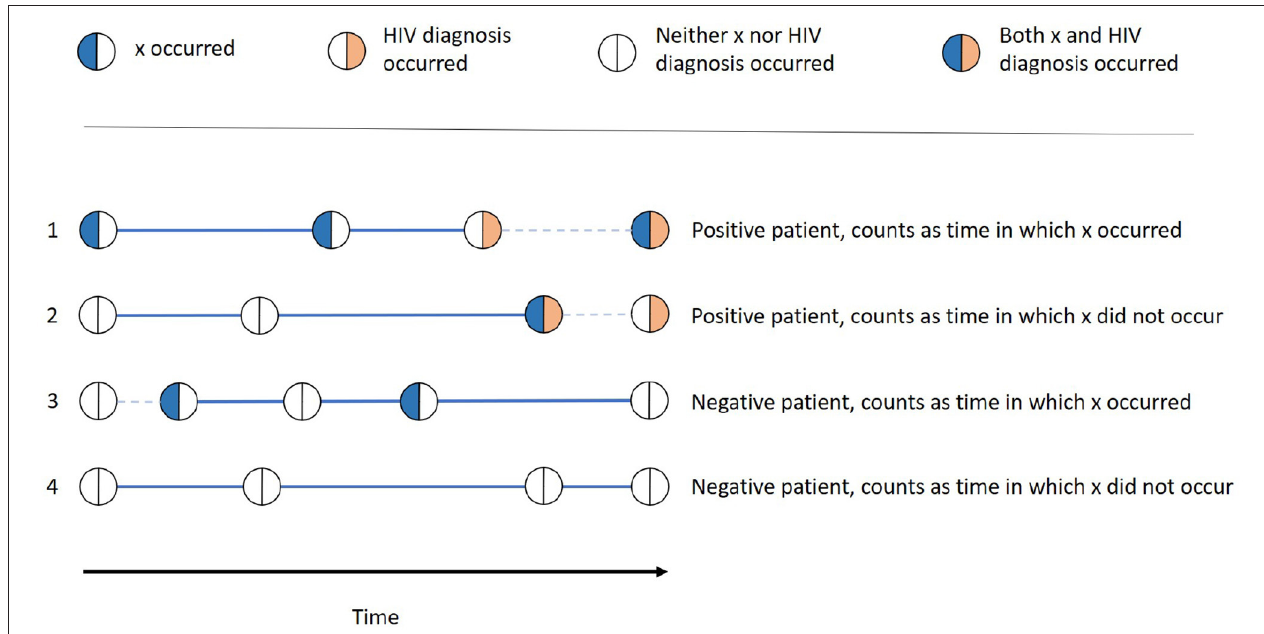
FIGURE 1 | Examples of all different possibilities of how one patient can be categorized into the groups x occurred, x did not occur, positive, and negative. The thick lines denote the time in which x occurred resp. did not occur, while the dashed lines denote the time that does not contribute to this patients time